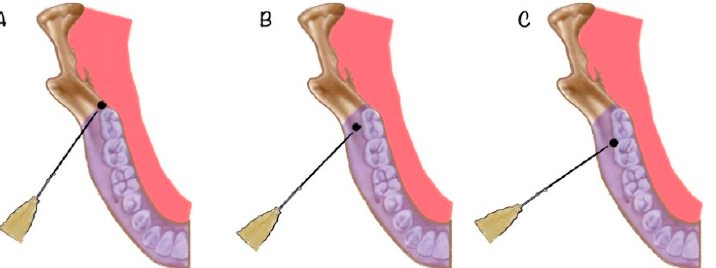
Figure 2. Illustration of the technique used. Presurgical periodontal submucosal infiltration of the blinded cartridge mixture (( A ) submucosal injection at the distal projection of the third molar; ( B ) submucosal injection in vestibular aspect of the lower third molar; ( C ) submucosal injection in mesial aspect of the lower third molar).